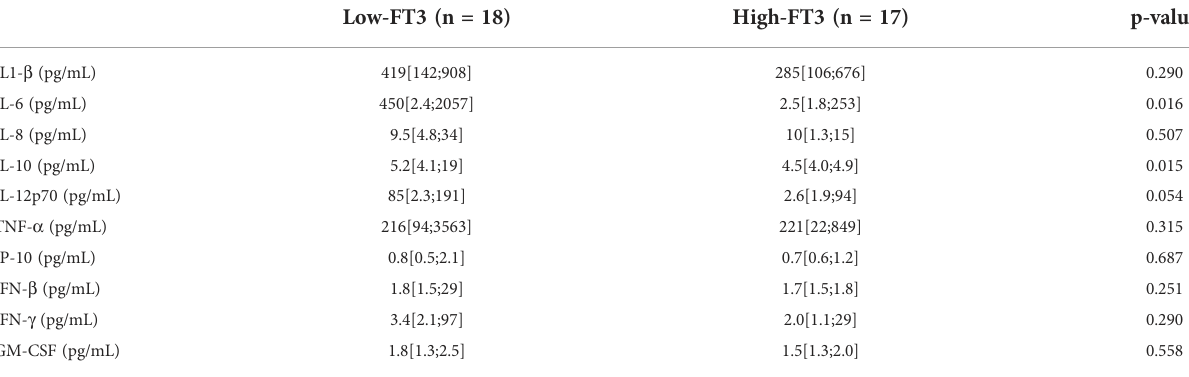
TABLE 6 Circulating antiviral cytokines levels in ward hospitalized Covid-19 patients.